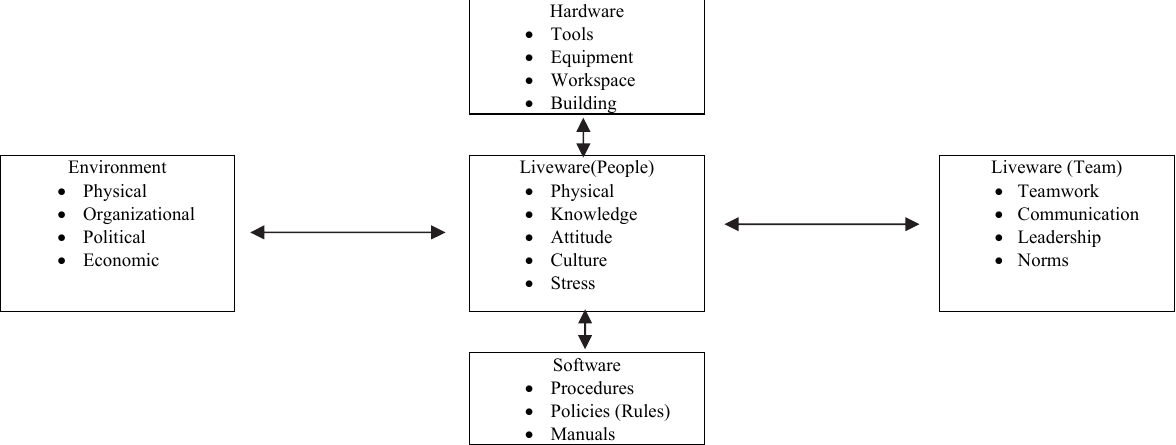
Fig. 1. The SHELL model (Shanmugam & Paul Robert,